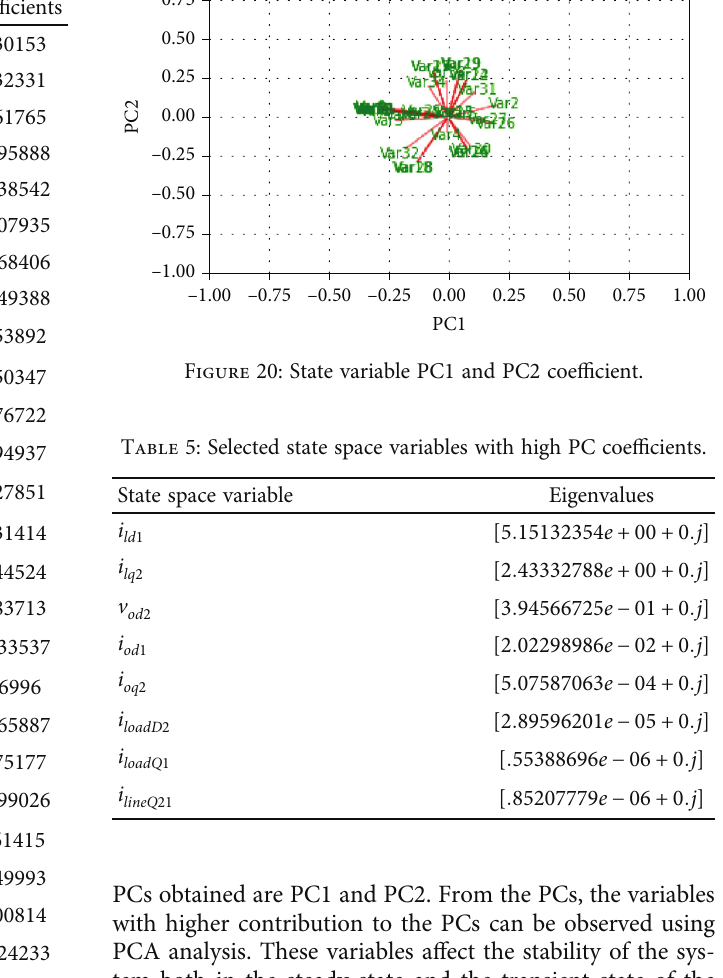
Table 4: State space variable and PC coe ffi cients.